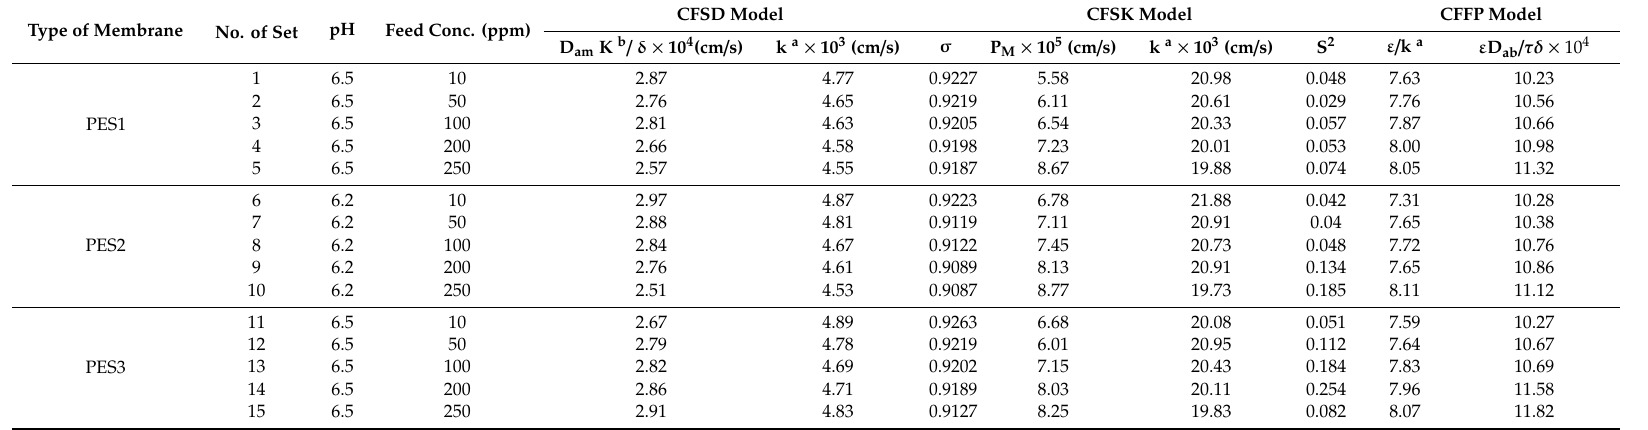
Table 4. Parameter estimated for various modules by a nonlinear estimated program (Cd 2 +